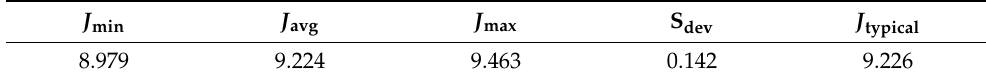
Table 7. Statistics regarding the optimum criterion.